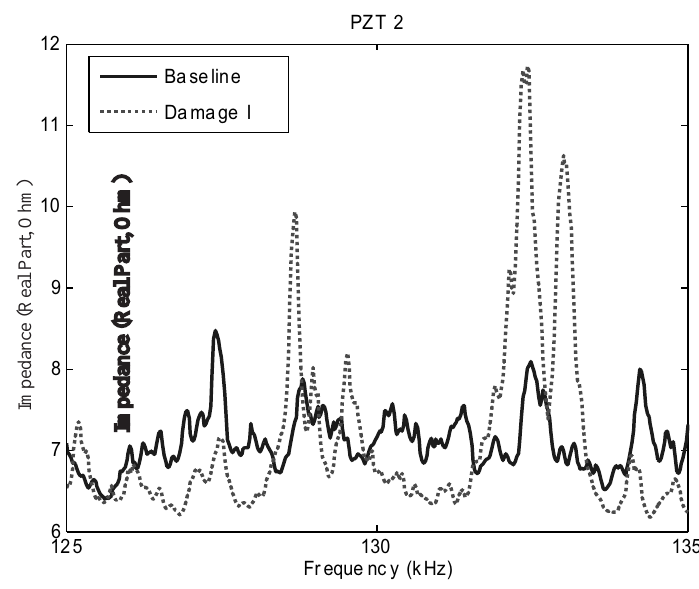
Fig. 3. Electrical Impedance measurement from PZT 2 before and after Damage I.